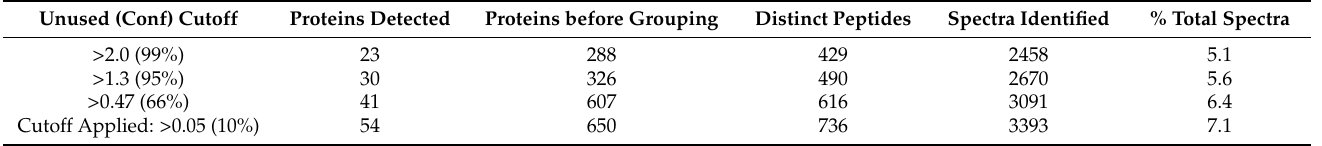
Table 3. ID Statistics (Protein-threshold) based on protein database of Malvaceae